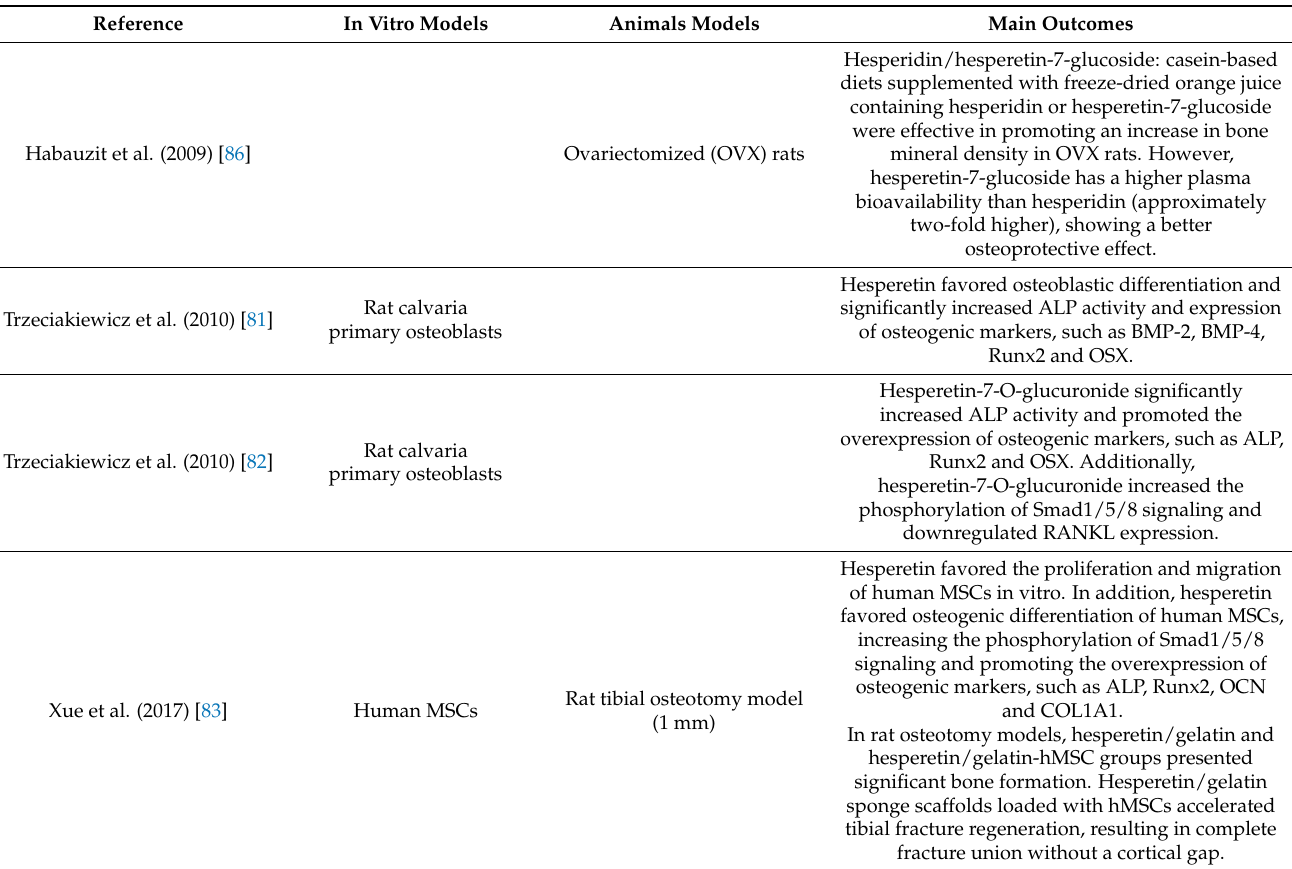
Table 3. In vitro and in vivo studies that evaluated the osteoprotective and anti-inflammatory effects of hesperetin and its